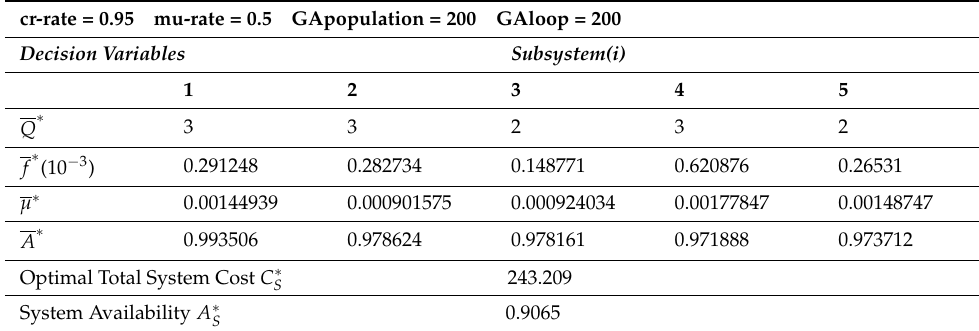
Table 6. Optimal Solutions obtained by ENUM–MGA for the n -stage standby